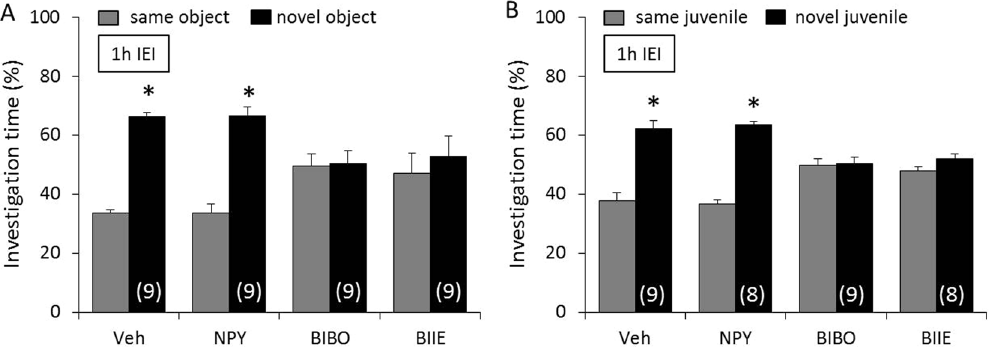
Figure 6. Y1 and Y2 receptor-mediated neuropeptide Y (NPY) neurotransmission is necessary for both non- social and social memory retrieval. Mice were infused icv with either vehicle (Veh; 2 µ l), NPY (1 nmol/2 µ l), BIBO (2 nmol/2 µ l), or BIIE (2 nmol/2 µ l) 10 min before the discrimination period of the object ( A ) and social ( B ) discrimination test, respectively. Intact memory and discrimination abilities are reflected by an increased investigation of the novel versus the same stimulus after an inter-exposure interval (IEI) of 1 h. Data represent means + SEM, and numbers in parentheses indicate group sizes. * p < 0.05 versus same